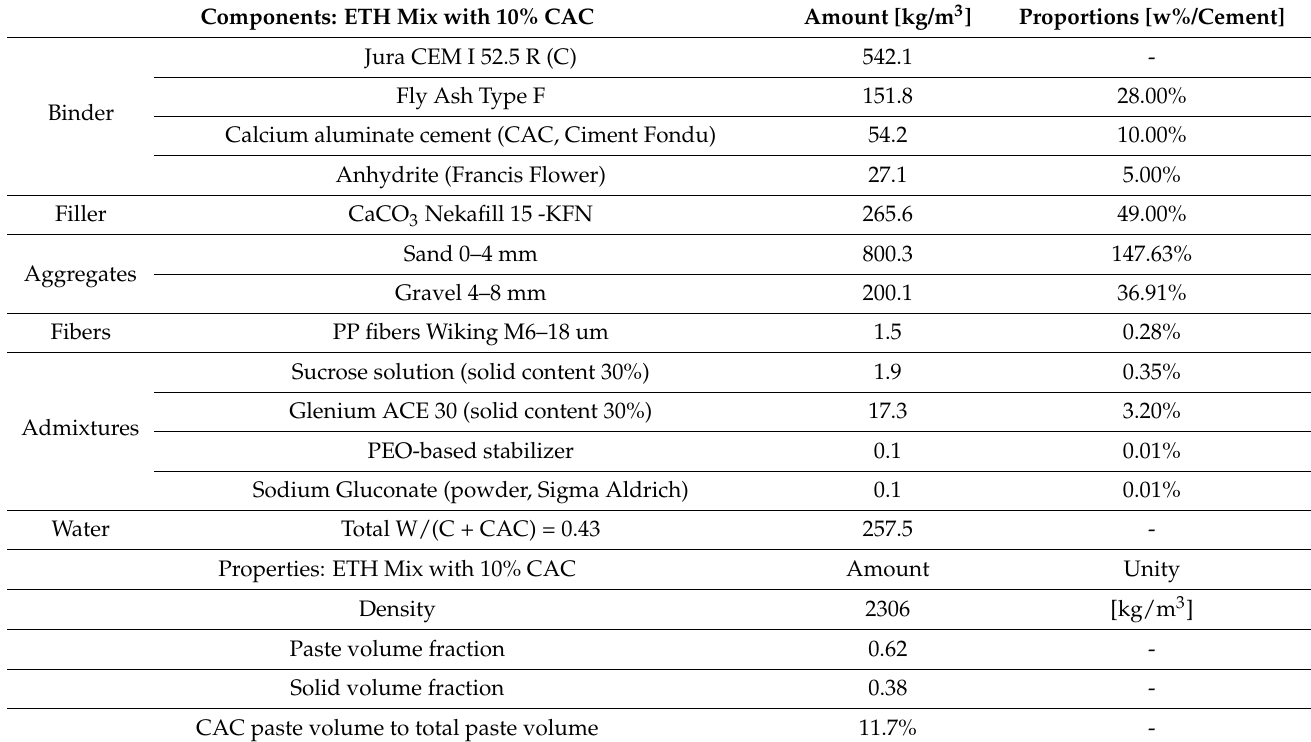
Table 3. Recipe for the final ETH mix with 10% CAC